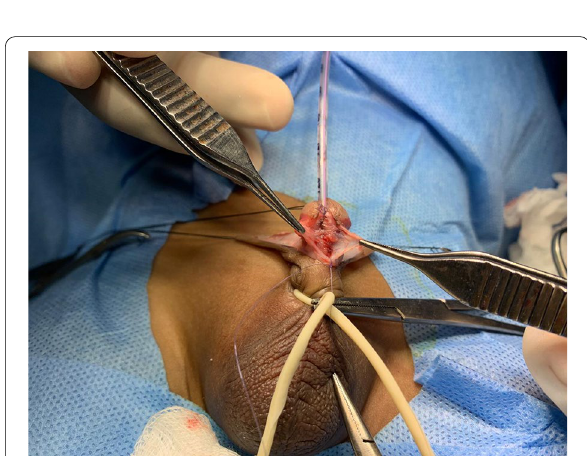
Fig. 4 Buck’s Fascia being sutured over the urethroplasty as an interposition layer. Note that Buck’s Fascia is a thick and well defined layer which does not need much dissection